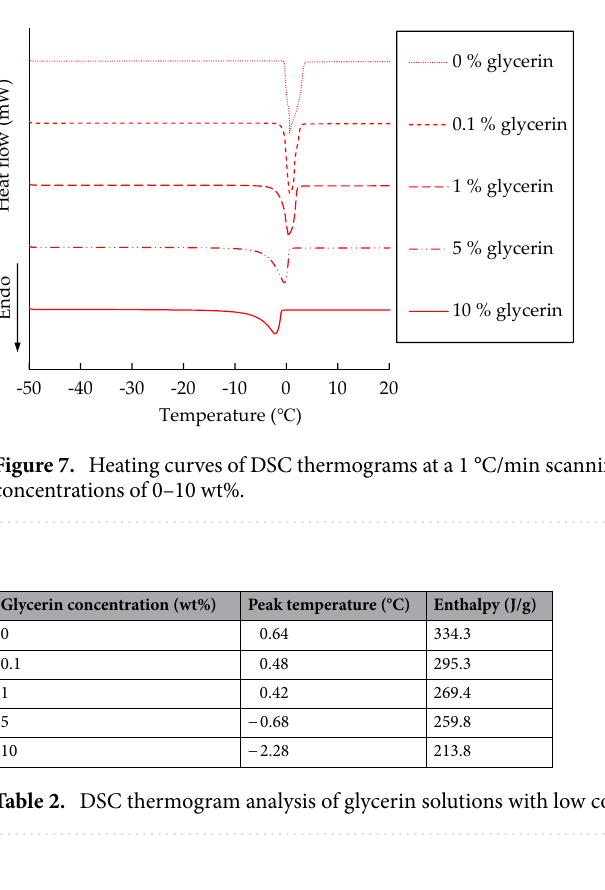
Table 2. DSC thermogram analysis of glycerin solutions with low concentrations.